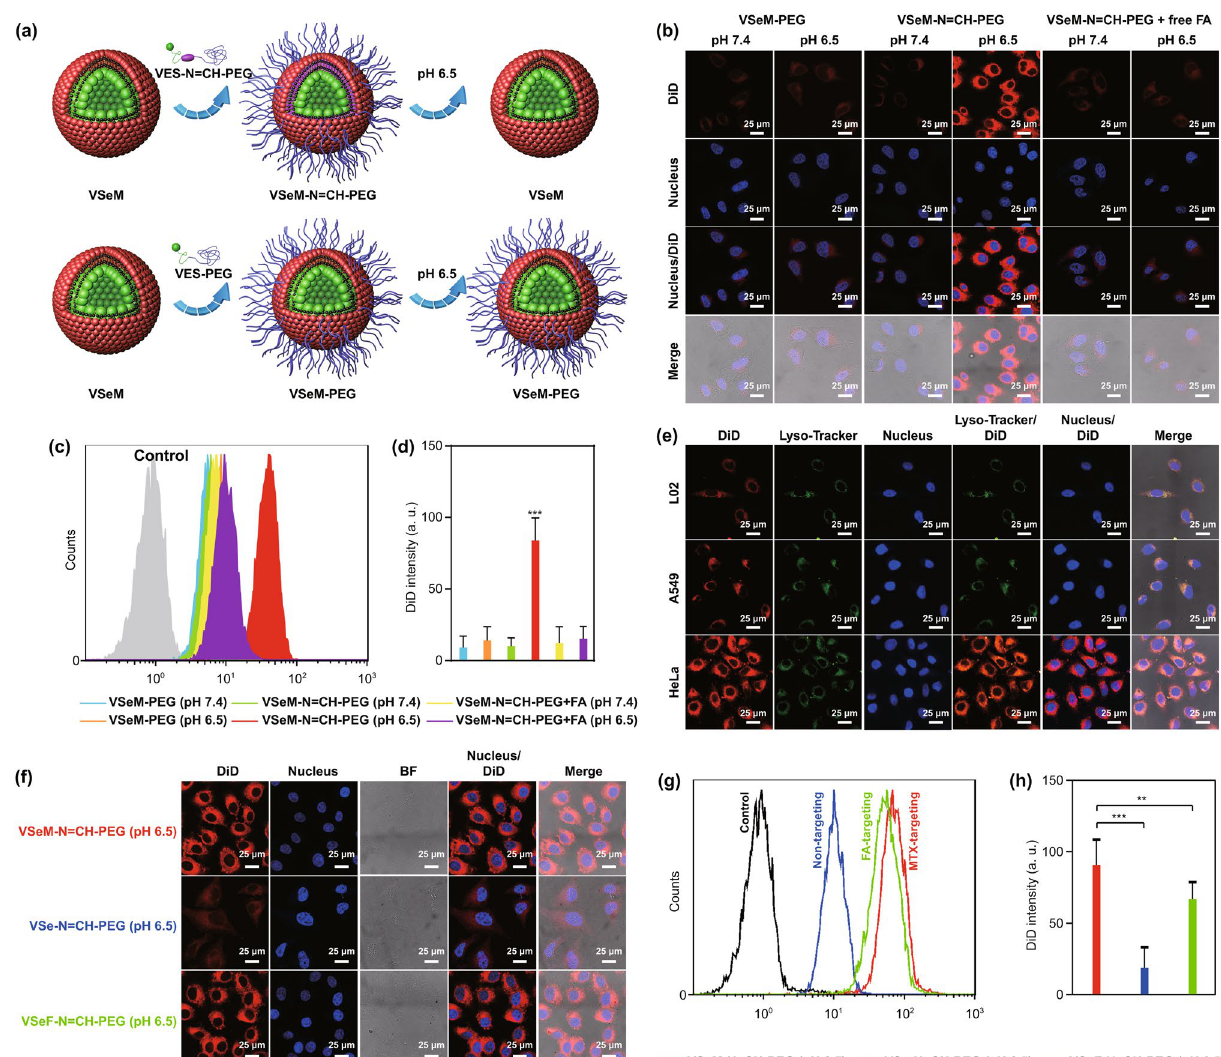
Fig. 2 Tumor acidity-responsive active self-targeting recovery and cellular uptake. a Illustration of targeting activation of VSeM-N=CH-PEG and targeting inactivation of VSeM-PEG under tumor acidic condition. b CLSM images, c flow cytometry profiles, and d average fluorescence intensity of HeLa cells incubated with DiD-labeled VSeM-PEG, VSeM-N=CH-PEG, and VSeM-N=CH-PEG with pretreatment of free FA for 4 h. e CLSM images of L02, A549, HeLa cells incubated with DiD-labeled VSeM-PEG, VSeM-N=CH-PEG, and VSeM-N=CH-PEG with pre- treatment of free FA at pH 6.5 for 4 h. f CLSM images, g flow cytometric profiles, and h average fluorescence intensity of HeLa cells incubated with VSe-N=CH-PEG, VSeF-N=CH-PEG, and VSeM-N=CH-PEG at pH 6.5 for 4 h. **, P < 0.01, ***, P <